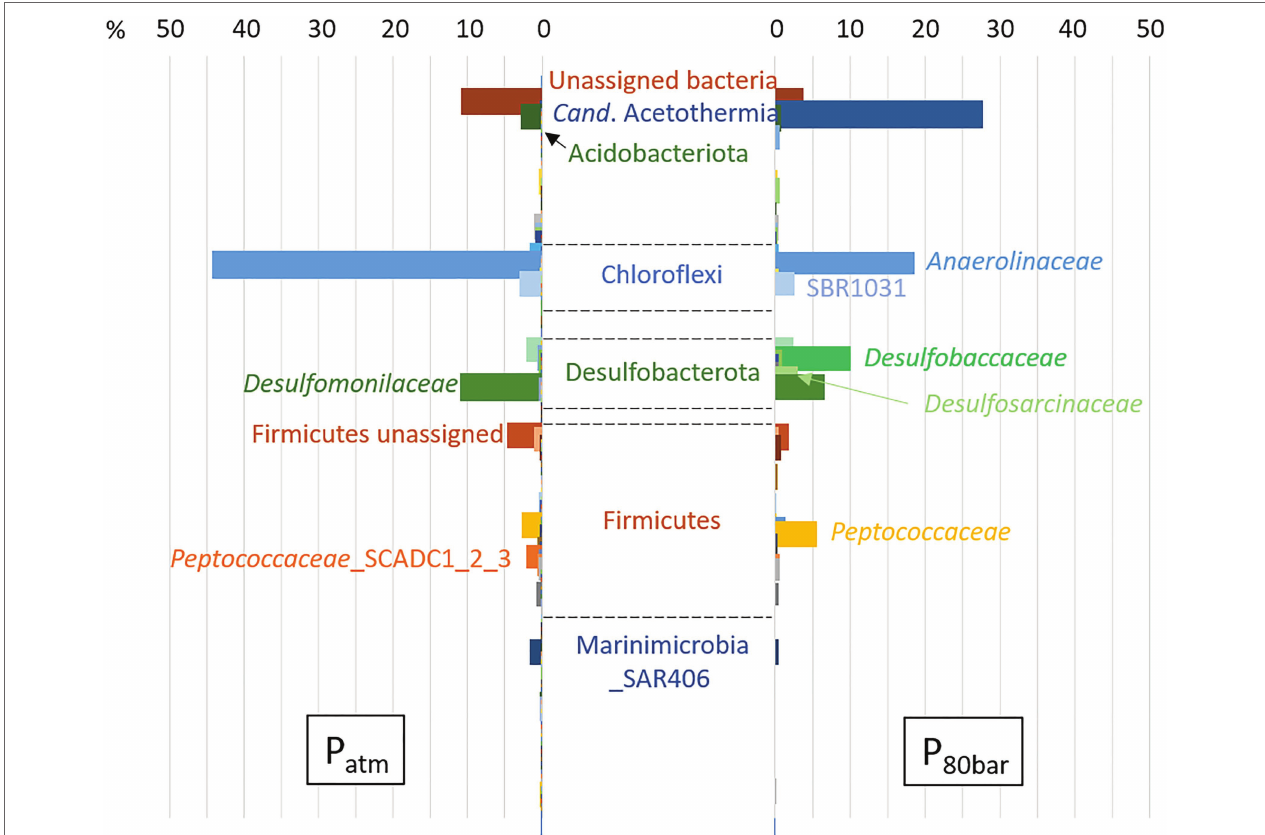
FIGURE 4 | Relative abundance of active BTEX-degrading bacterial populations from a deep aquifer with or without pressure (90 bar). The percentage is shown on the X-axis. Total RNA was extracted from both communities, and taxonomic diversity analysis was performed based on 16S rRNA transcripts. The archaeal fraction accounted for less than 0.03% of